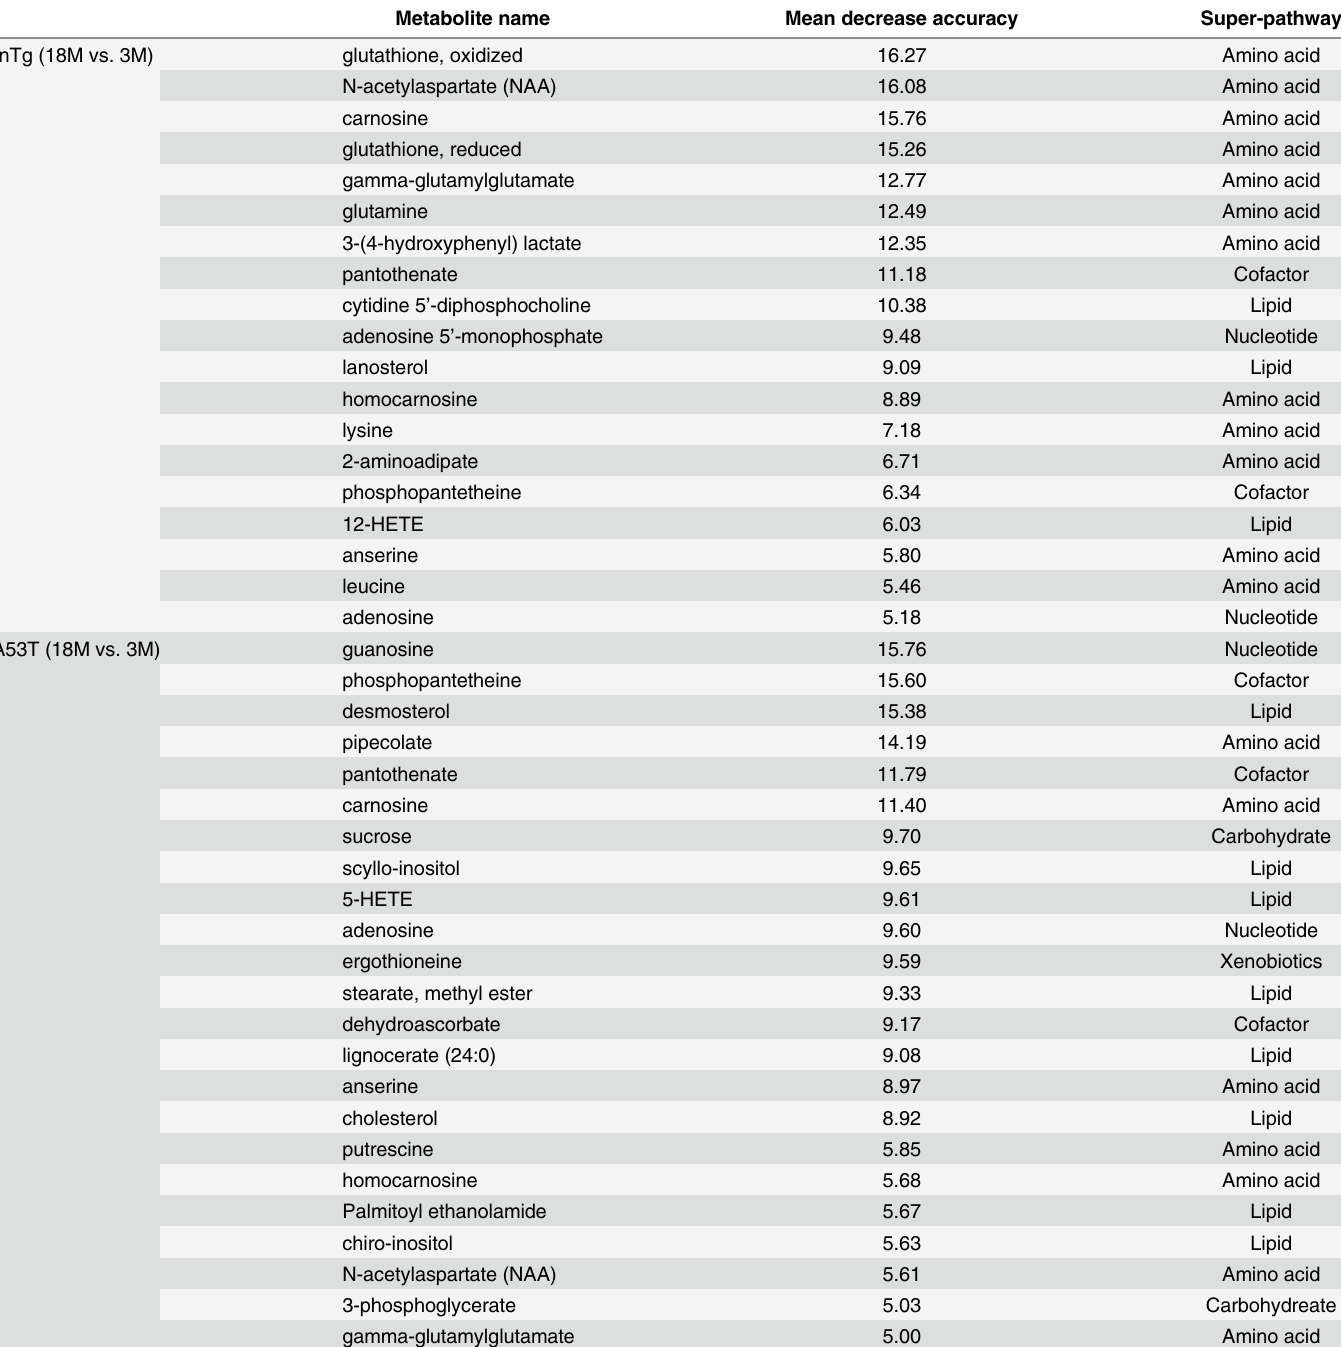
Table 2. A list of metabolites substantially affected by aging based on the Random Forests test. Metabolite